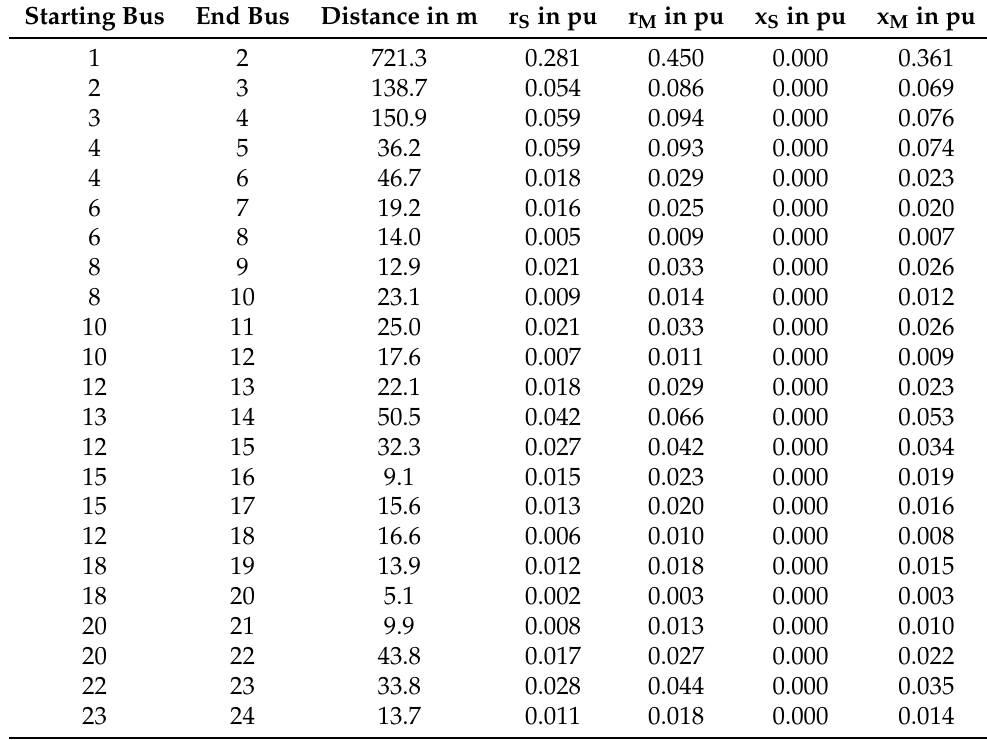
Figure 6. Single-phase representation of the considered low voltage feeder. Table 5. Overview of used cable